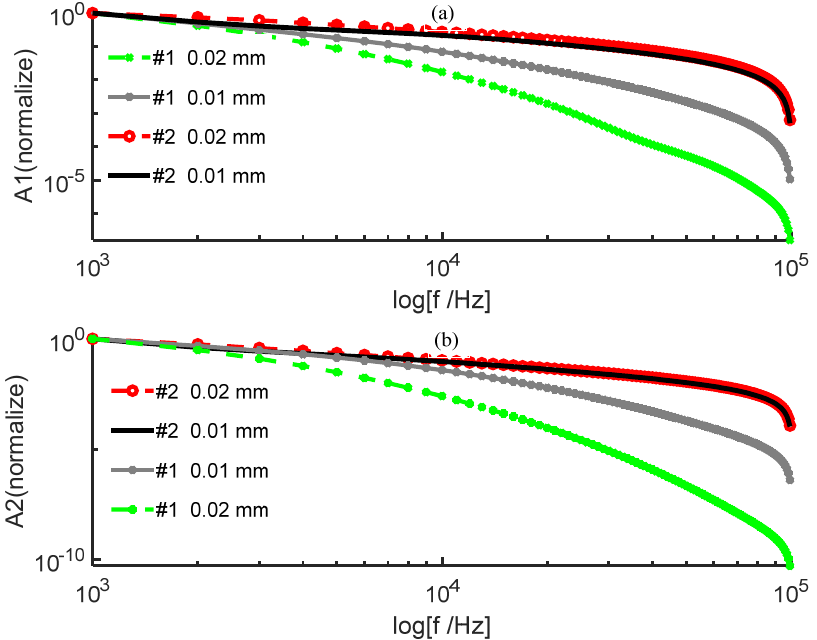
Figure 3. Variation in the amplitude of the posterior surface of the wine − discolored samples with frequency for different sample thicknesses: ( a ) fundamental frequency wave; ( b ) second harmonic (high frequency).